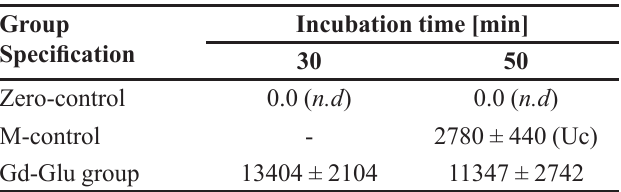
TABLE I – Metal mass concentrations, in µ g.g -1 , of dried cell mass at the three groups: Zero-control, M-control, and Gd-Glu for incubation times of 30 and 50 min.